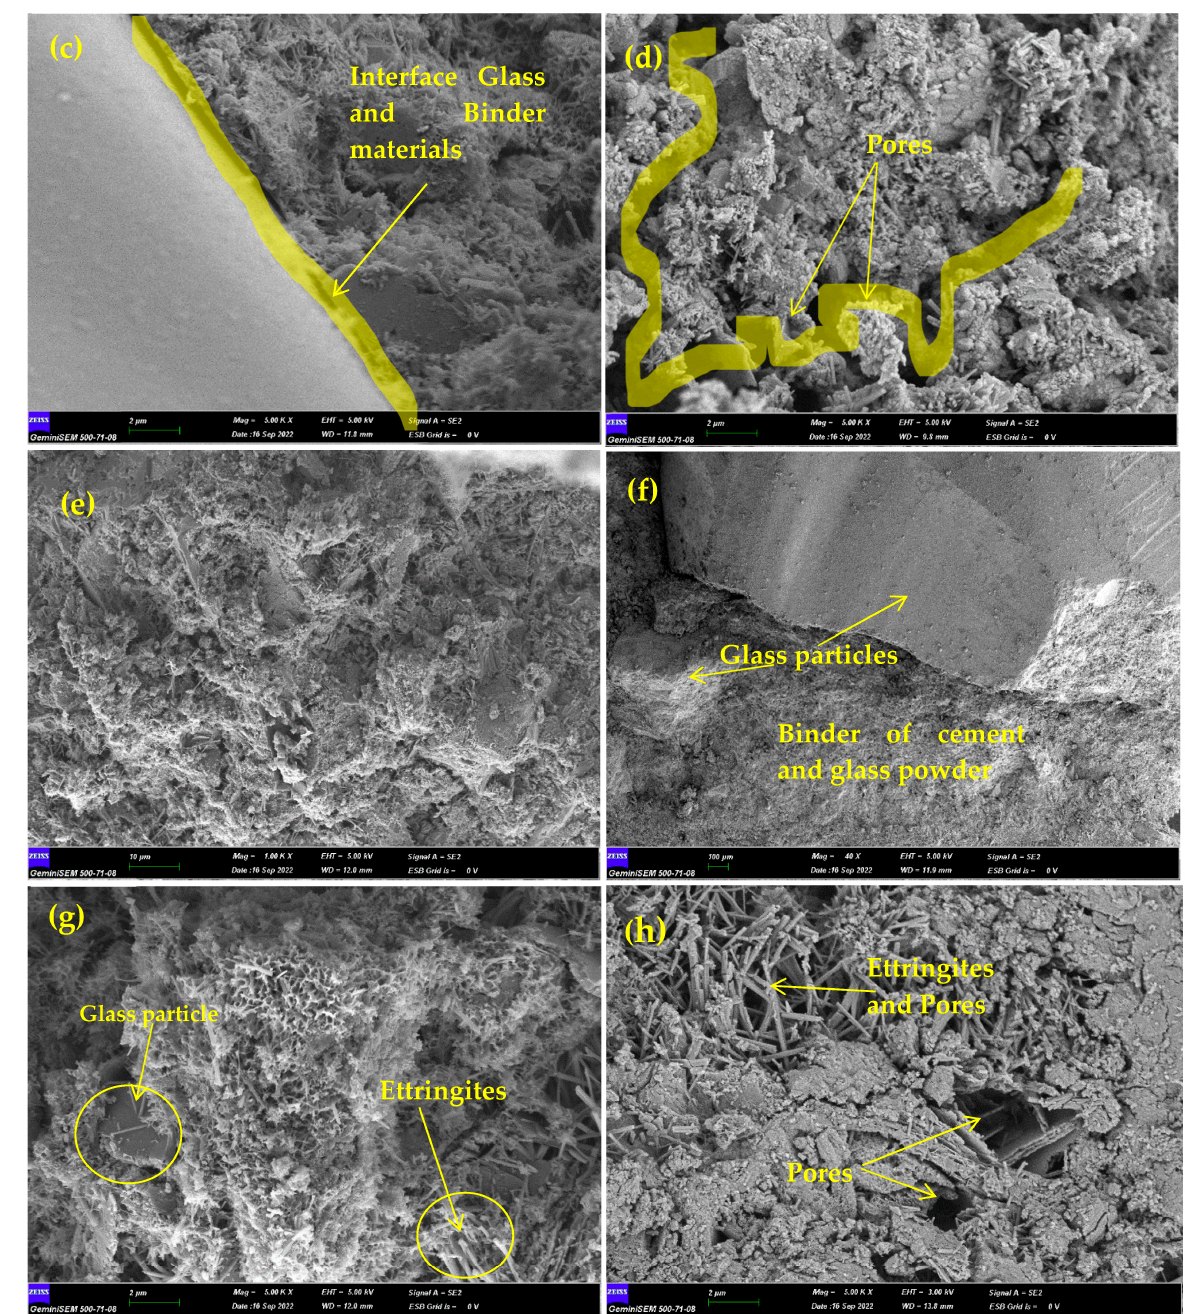
Figure 7. Consequences of SEM